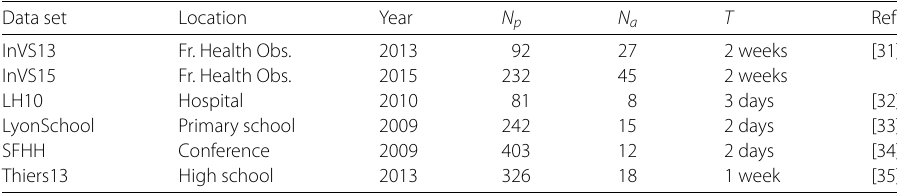
Table 1 Characteristics of the data sets Data set Location Year N p N a T Ref InVS13 Fr. Health Obs. 2013 92 27 2 weeks [31] InVS15 Fr. Health Obs.